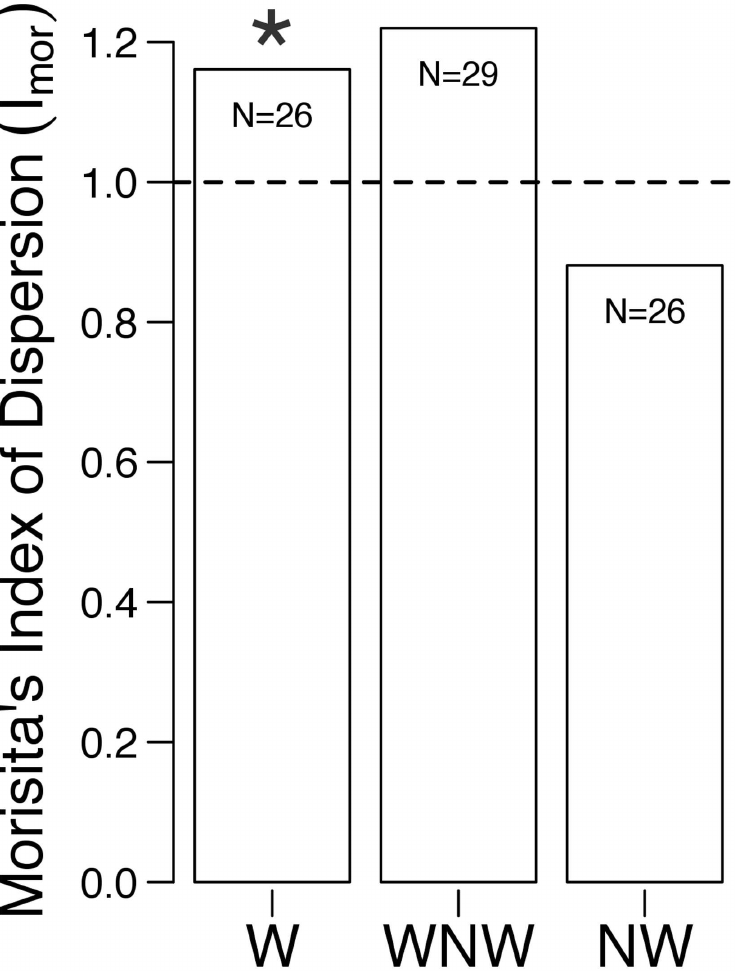
WNW = non-walking clams in ‘walking’area. Dashedline demarcates transition from a random(I M = 1) to an aggregateddistribution (I M > 1); asterisk denotesa significant χ 2 test: p =